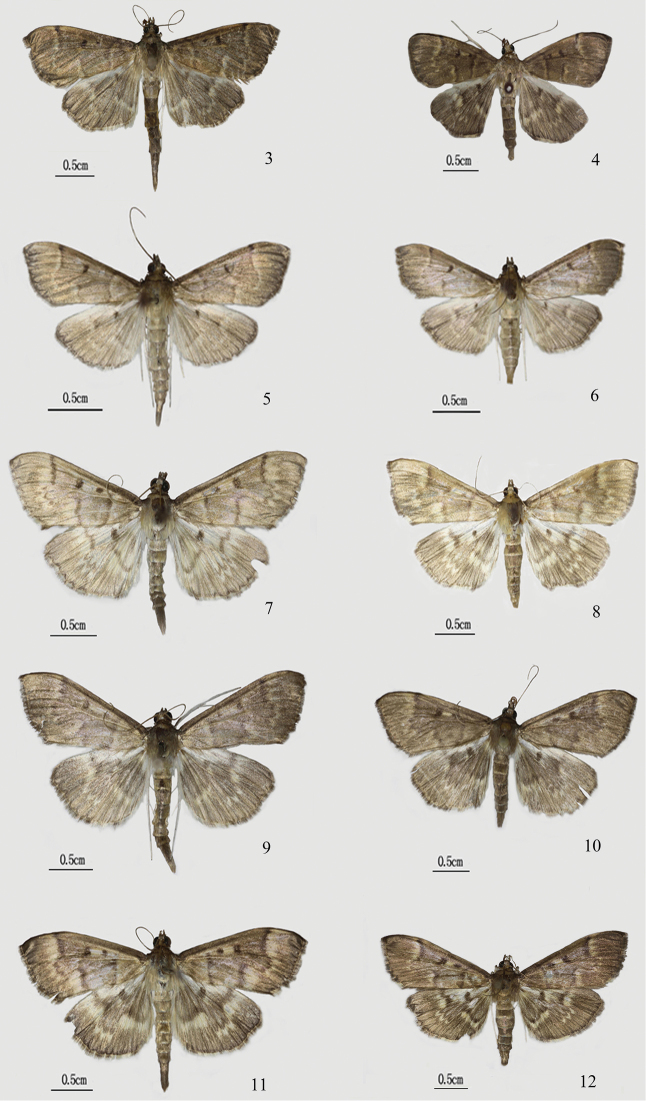
Habitus of Herpetogramma species 3, 4H.biconvexa sp. nov. 3 male, holotype 4 female, paratype 5, 6H.rudis5 male 6 female 7, 8H.longispina sp. nov. 7 male, holotype 8 female, paratype 9, 10H.brachyacantha sp. nov. 9 male, holotype 10 female, paratype 11, 12H.magna11 male 12 female.